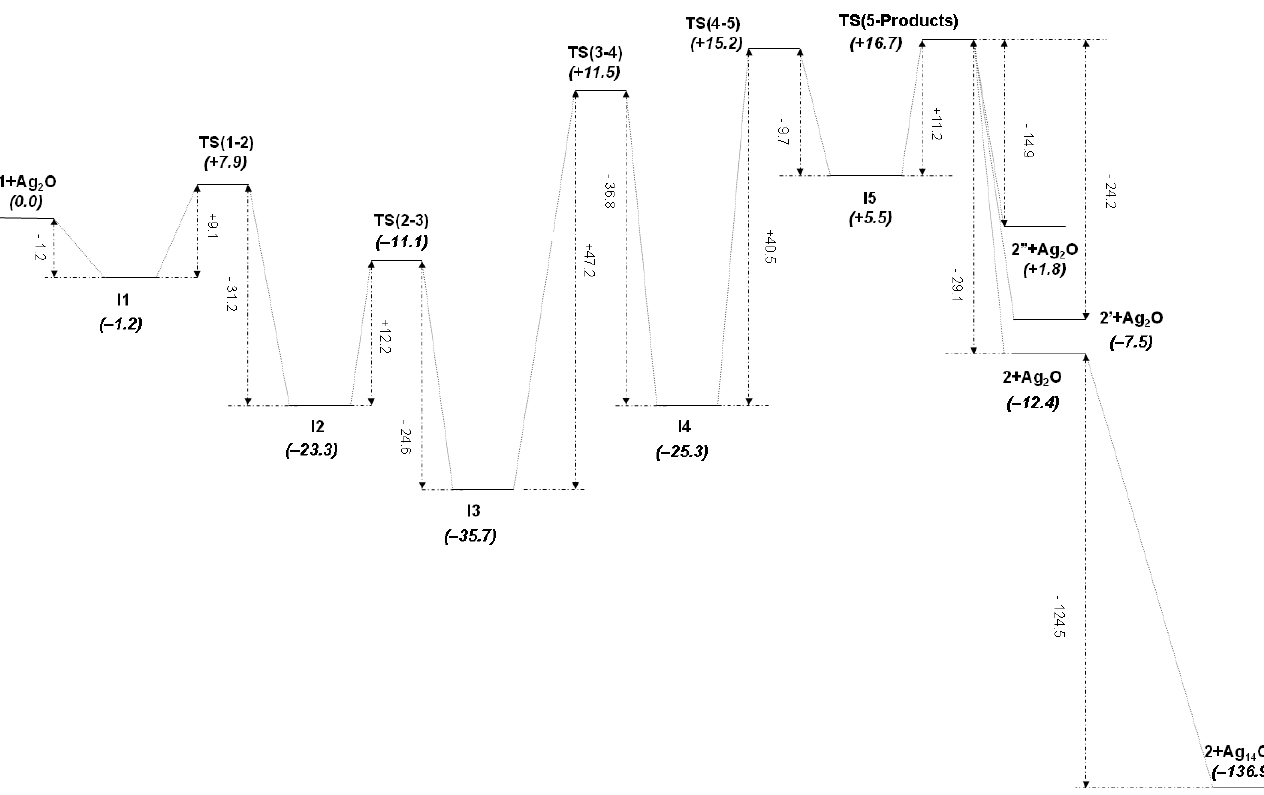
Figure 3. Graphic representation of the M1 mechanism at the B3P86-D3(BJ)/6-311++G(2df,2pd), AQZP(Ag) level of theory ( ∆ G 0 298 values in kcal mol − 1 ). Table 1. Selected bond lengths (Å) of theoretically optimized structures (B3P86/6-31+G(d),